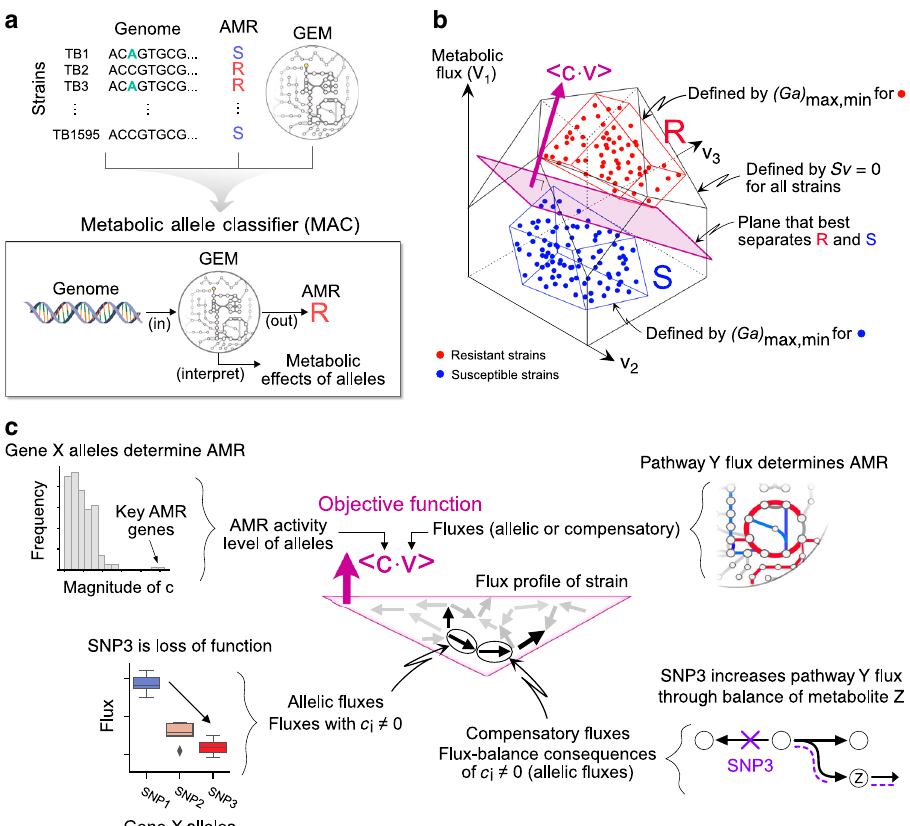
Fig. 1 A metabolic systems approach for genetic associations. a In this study, data describing TB genome sequences and AMR data types are integrated with a metabolic model to learn a biochemically-interpretable classi fi er, named Metabolic Allele Classi fi er (MAC). The MAC parameters consist of allele- speci fi c fl ux capacity constraints, a , and an antibiotic-speci fi c metabolic objective, c , both of which are inferred from the data. b The optimal MAC describes strain-speci fi c polytopes in fl ux space that separate into resistant (R) and susceptible (S) regions. The MAC objective function, c T v , is identi fi ed as normal to the plane that best separates R and S. c The learned MAC provides a biochemically-based hypothesis of AMR mechanisms and allele-speci fi c effects through interpretation of c and v . The genome-scale fl ux state of a strain, v , consists of fl uxes that are directly activated by alleles (allelic fl uxes) and those that are fl ux-balance consequences of the allele-activated fl uxes (compensatory fl uxes). Abbreviations: S, susceptible; R, resistant; AMR, antimicrobial